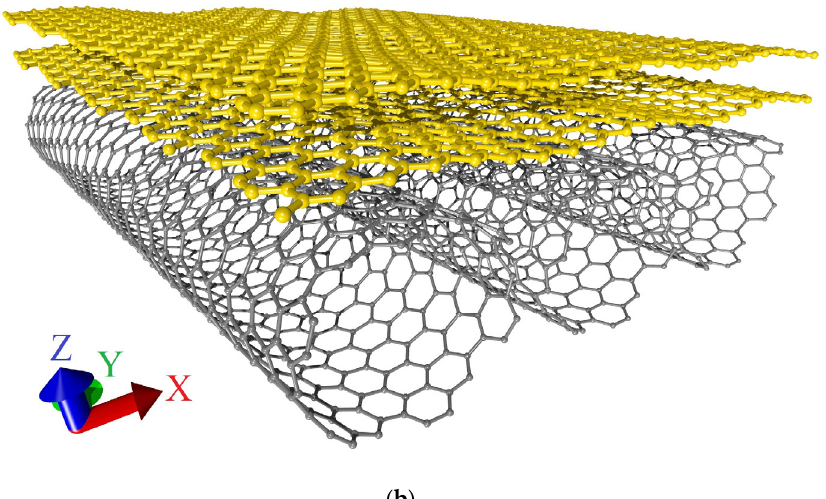
Figure 11. Extended fragments of the atomic structure of bilayer graphene-SWCNT (12,6) hybrid fi lms with island topology: ( a ) model V1; ( b ) model V2.